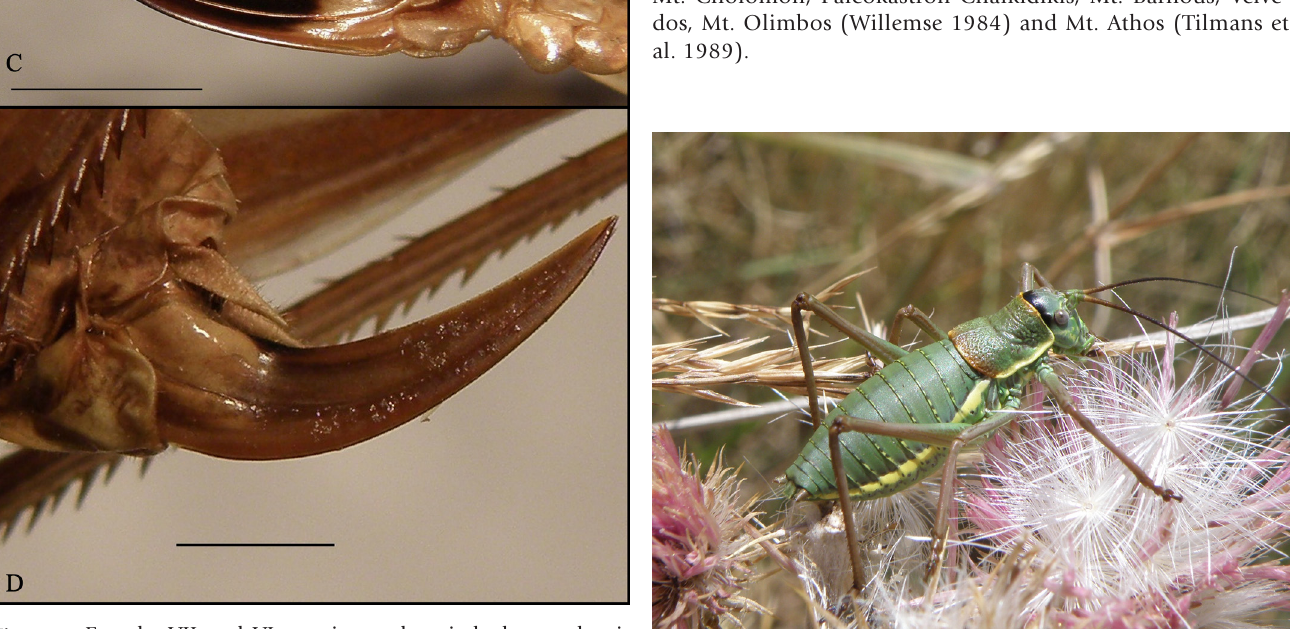
Figure 8. Female, VII and VI sternites, subgenital plate and ovi- positor, lateral view A . Platycleis affinis affinis (scale bar: 10 mm), B . Platycleis grisea (scale bar: 5 mm), C . Platycleis escalerai escalerai (scale bar: 5 mm), D . Incertana incerta , (scale bar: 2 mm).